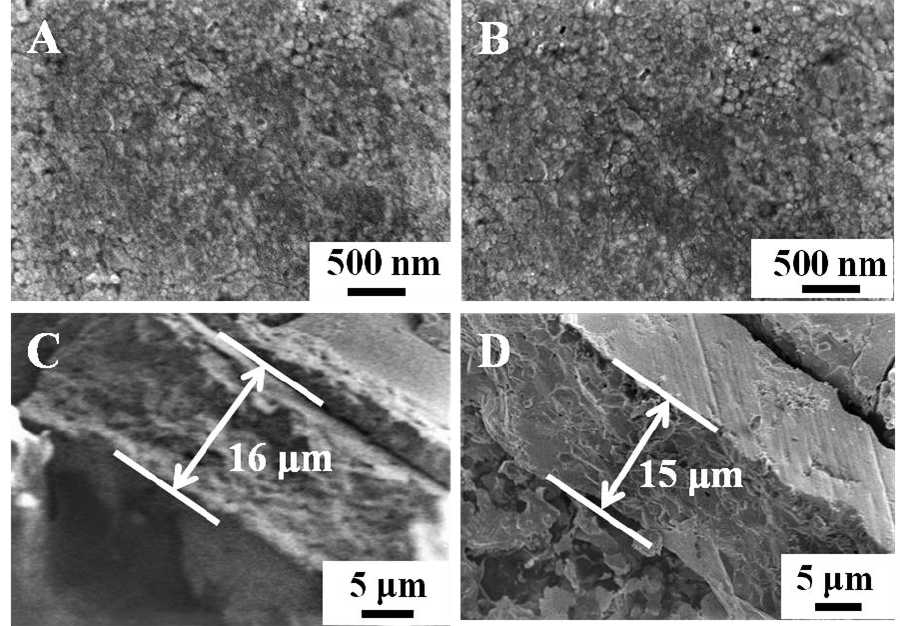
Figure 1. ( A , B ) show SEM images of the BVO (C) and Mo-BVO (C) ceramics fabricated by the BiVO 4 precursor powders. ( C , D ) show cross-sectional images of the as-prepared BVO (C) and Mo-BVO (C).